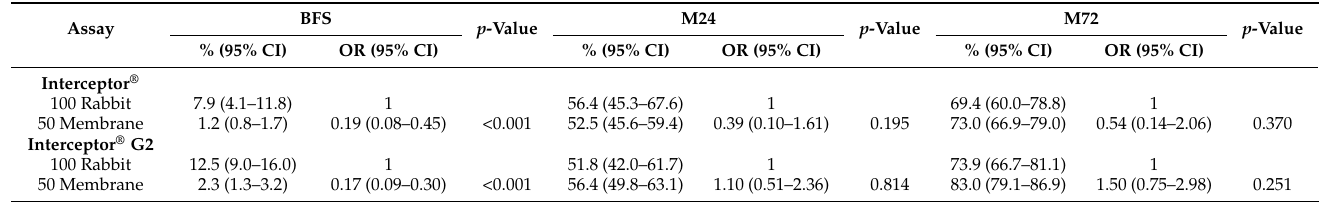
Table 6. Comparison of the membrane assay to the gold standard with rabbit assay. The difference in the odds of mosquito mortality at 24-h (M24) and 72-h (M72) and blood feeding success (BFS) for resis- tant Anopheles arabiensis was measured between the gold standard rabbit assay with 100 mosquitoes Table 7. Superiority of Interceptor ® G2 over Interceptor ® was estimated by comparing the membrane and the membrane assay with 50 mosquitoes *. assay to the gold standard assay with pyrethroid-resistant mosquitoes. The difference in the odds of mosquito at 72-h (M72) and blood feeding success (BFS) for resistant Anopheles arabiensis measuring the superiority of Interceptor ® G2 and Interceptor ® with the gold standard with 100-rabbit compared to 50-membrane bioassays *.